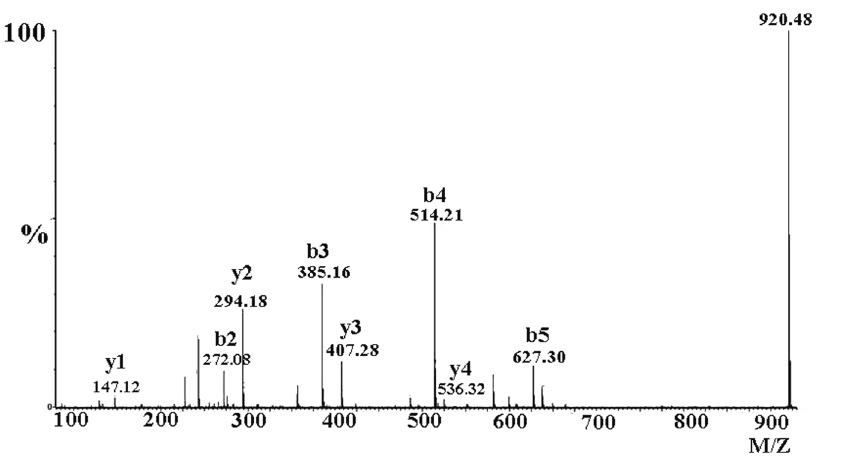
Figure 4. MS/MS spectrum for sequence determination of the N-terminal fragment of reduced and carboxamidomethylated mHWTX-IV. Sequence was derived from the series of b-ions and y-ions.